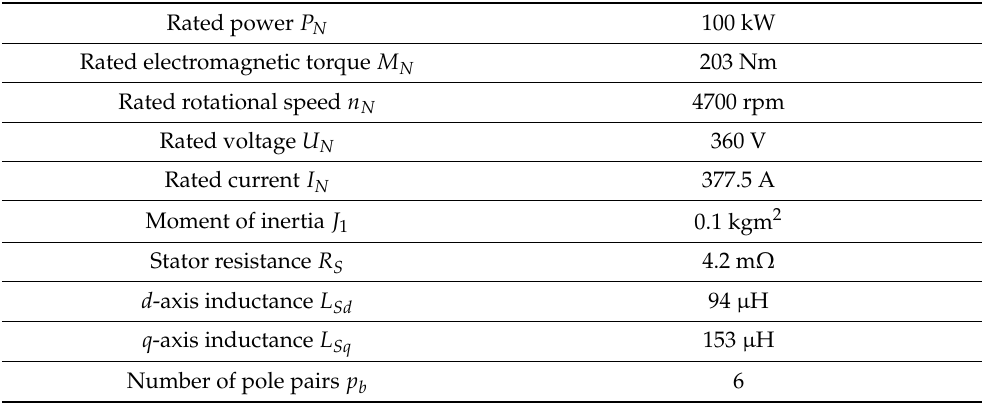
Table 3. List of parameters for PMSM with surface magnets.